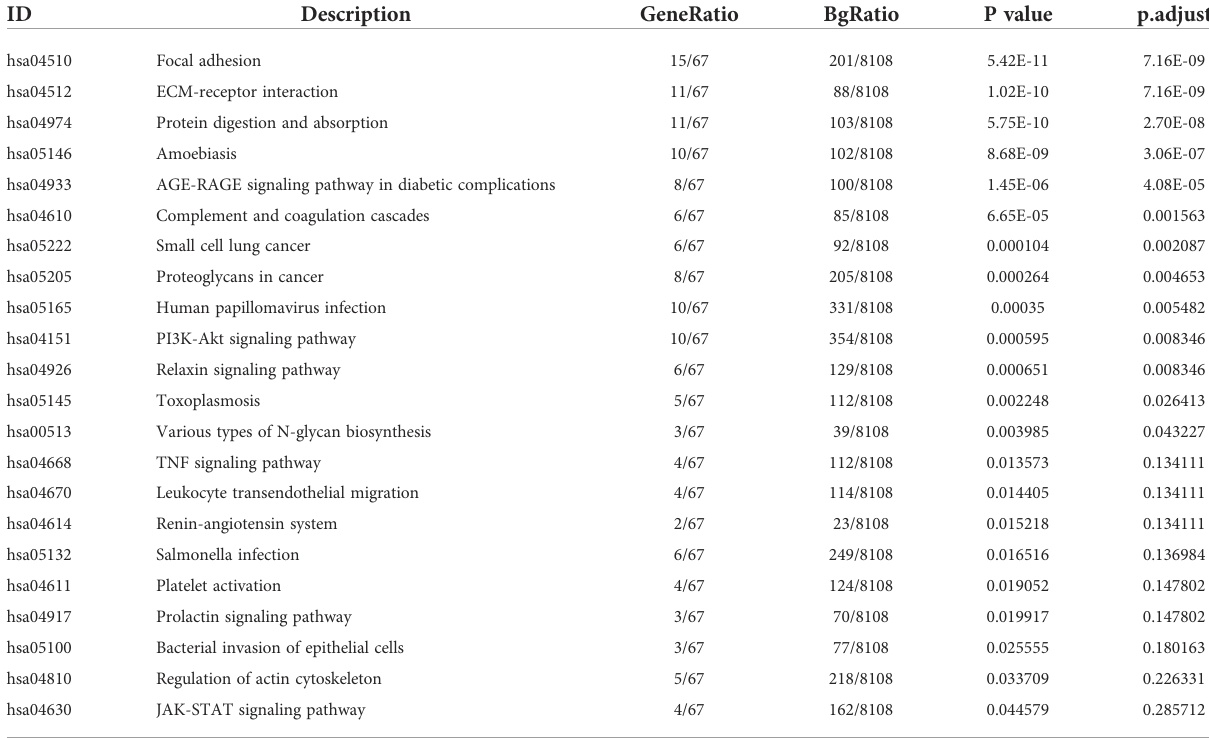
TABLE 3 KEGG pathway involved in glioma based on the expression level of COL6A2.